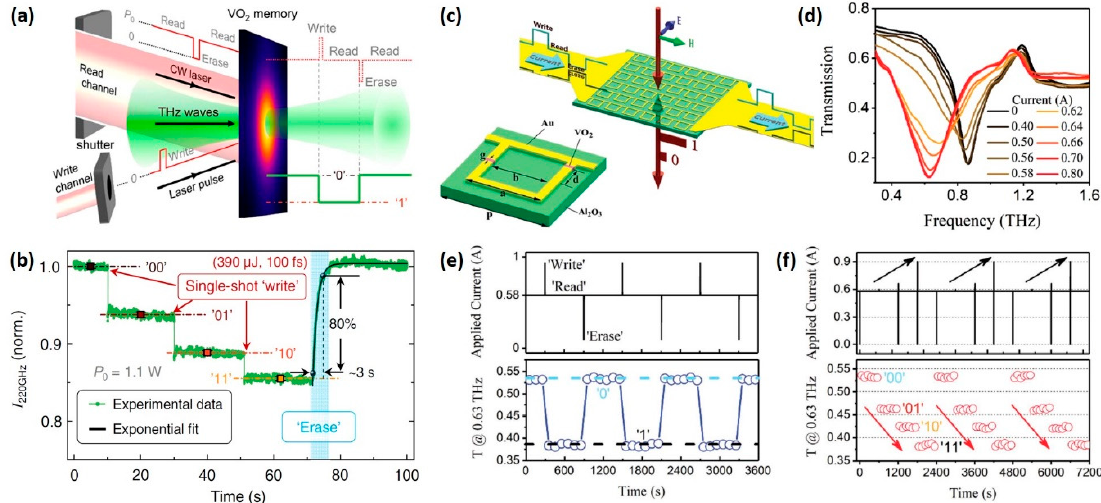
Figure 14. THz memorizer based on the phase transition of VO 2 . ( a ) Schematic of the all-optically driven 2-bit memory device based on VO 2 film. A continuous-wave laser as a read channel provides a constant bias power P0 to maintain the temperature of VO 2 film at the percolation threshold of IMT, and shutting off P0 means the “erase” operation. The states of VO 2 film are written by fs laser (1560 nm) and detected by transmitted THz waves (220 GHz) in real time. ( b ) Time-dependent 2-bit memory effect of VO 2 written by three fs pulses. The bias pump power is P0 = 1.1 W, the writing pulse fluence is 5.5 mJ/cm 2 , and the pulse duration is 100 fs. The exponential fit (thick black curve) to the data after the “erase” execution demonstrates the thermal equilibrium time of ~3 s, according to the 10–90% criterion. Reproduced from [33], with permission from Optical Society of America 2020. ( c ) Schematic of the electric filed controlled meta-device fabricated by VO 2 hybrid asymmetric split-ring resonators (VO 2 -ASRR) and a single unit of the VO 2 -ASRR. ( d ) Frequency spectrum as a function of applied current. ( e ) Timing diagram of the binary programming process. Applied current pulses: 1 A (1 s) for “write,” 0 A (2 s) for “erase,” 0.58 A for “read,” (continuous bias). The state of the metadevice was detected by the THz transmission at 0.63 THz. ( f ) Timing diagram of the 2-bit programing process. Applied current pulses: 0–0.58 (“00”)—0.6–0.58 (“01”)—0–0.66–0.58 (“10”)—0–0.9–0.58 A (“11”). Four states denoted as “00,” “01,” ”10” and “11” can be distinguished by the THz transmission amplitude at 0.63 THz. Reproduced from [35], with permission from WILEY-VCH 2018.